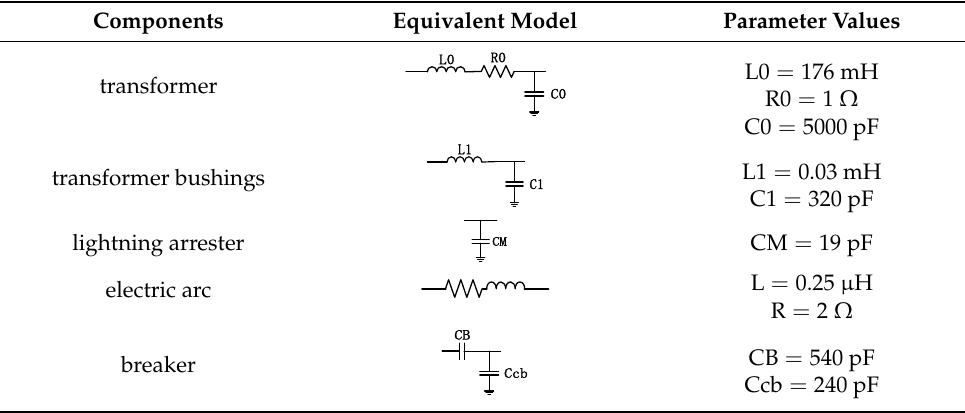
The VFTO at the transformer entrance is a high-frequency oscillation superimposed on the sine waveform, and its maximum amplitude can reach 1.24 pu. Figure 5 is the frequency spectrum of VFTO waveform. Through analysis, the VFTO waveform has rich frequency components, mainly concentrated in 500 kHz to 20 MHz, as shown in Table